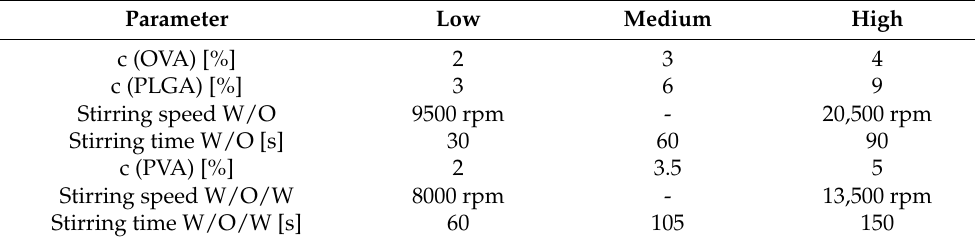
Table 2. Parameter settings of the definitive screening design.